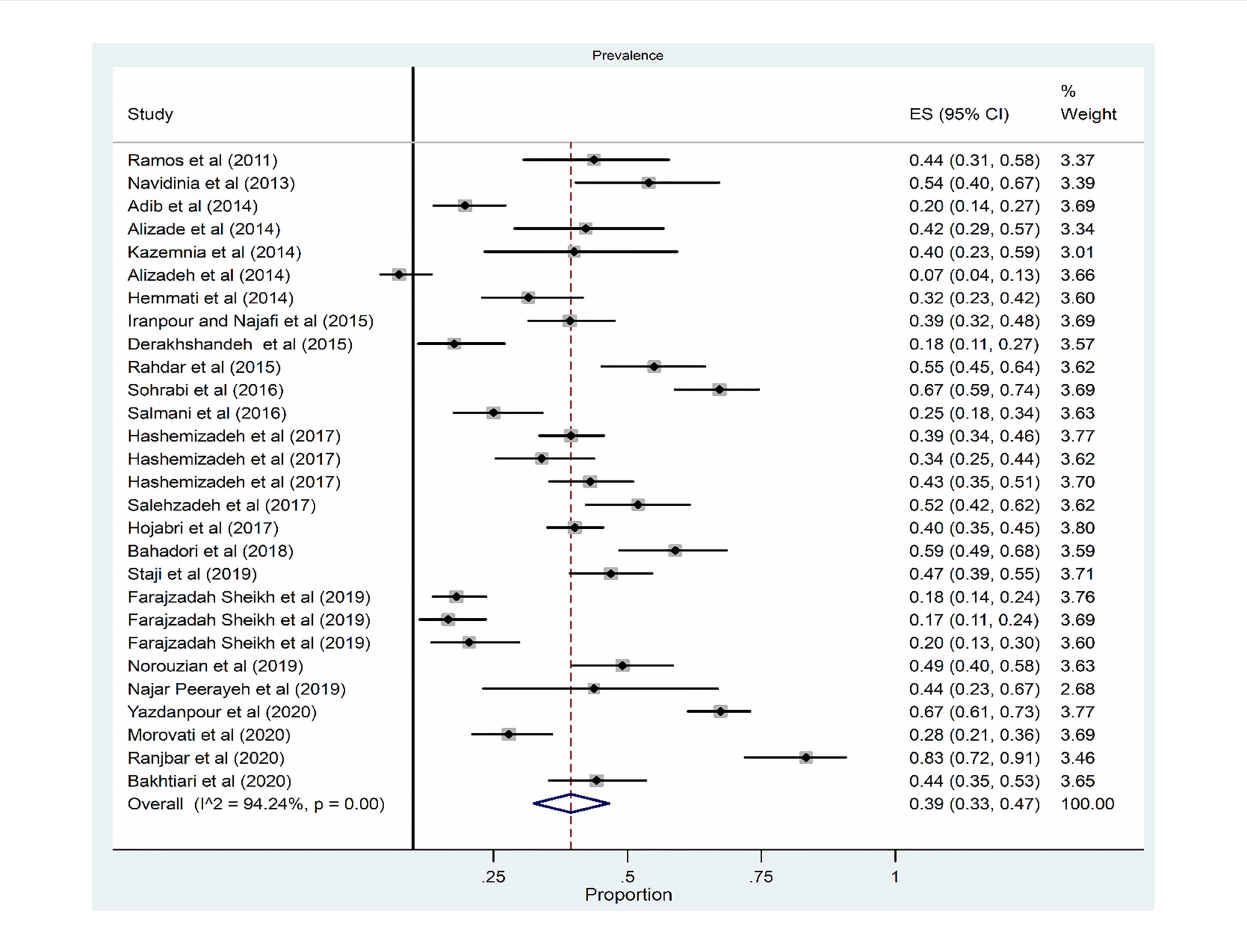
FIGURE 2 | Forest plot of the meta-analysis of phylogroup B 2 prevalence among UPEC